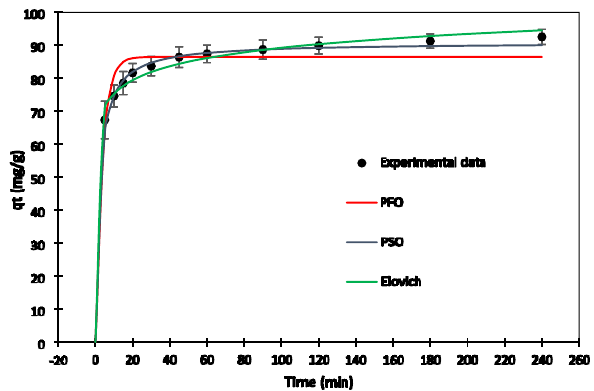
Figure 7. Kinetic data from Pb 2+ adsorption onto AHCop (T = 25 °C). Error bars represent the standard deviation of three repeated experiments.